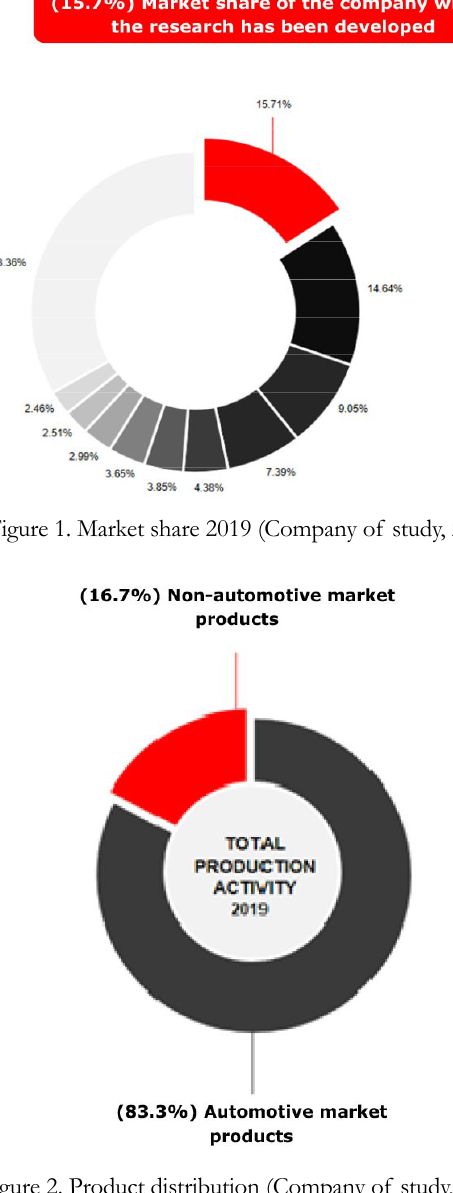
Figure 2. Product distribution (Company of study,